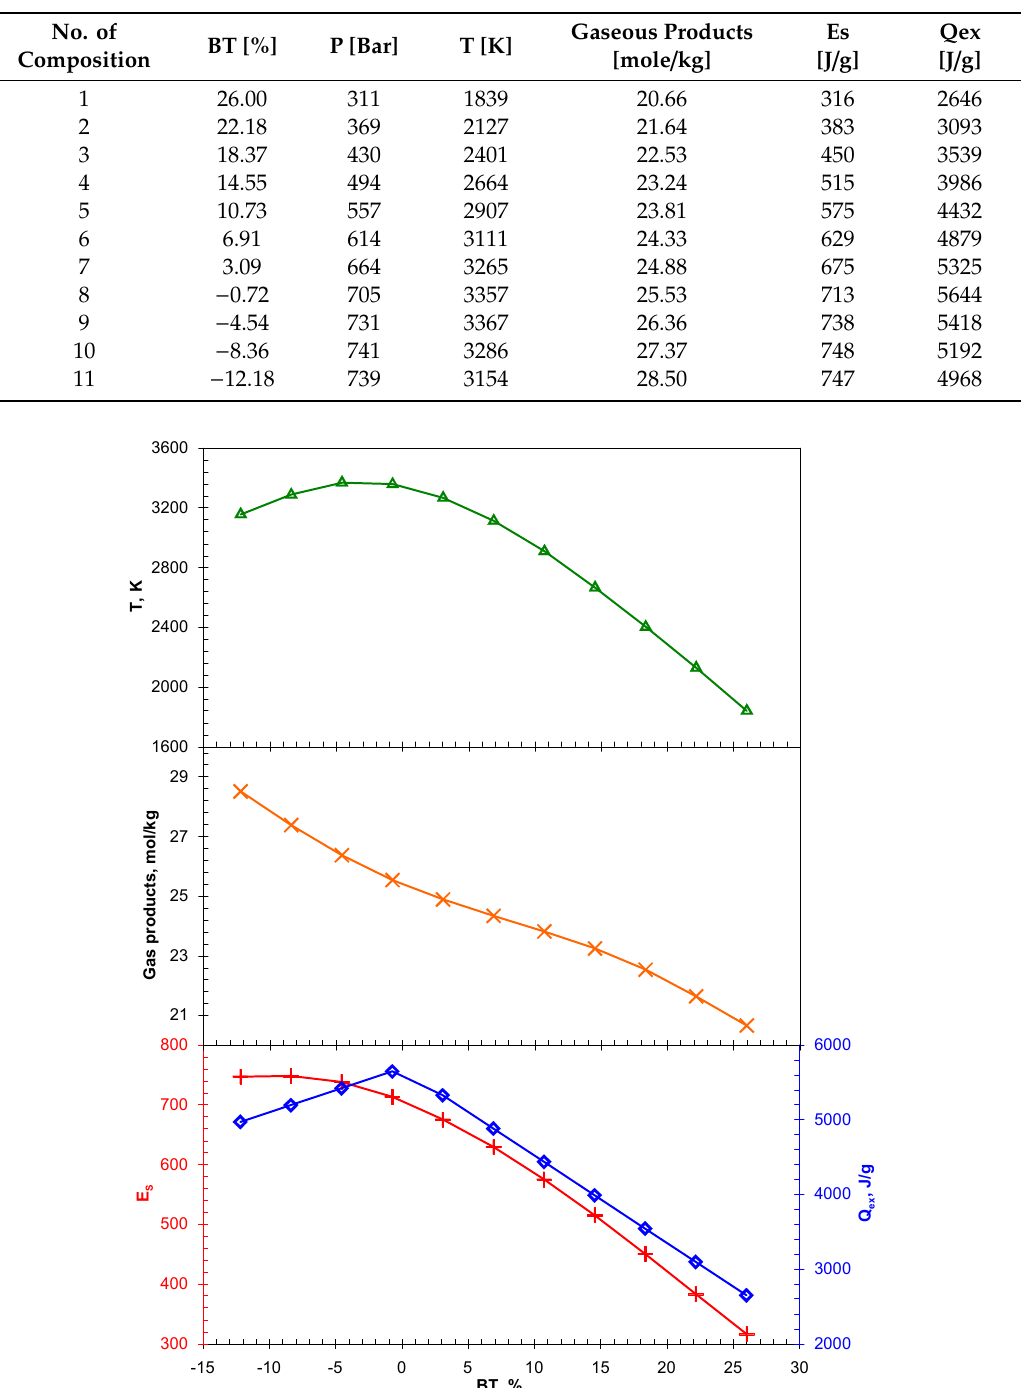
Table 2. Results of thermodynamic parameter calculations for gas-generating tested mixtures (Adapted from [15]).